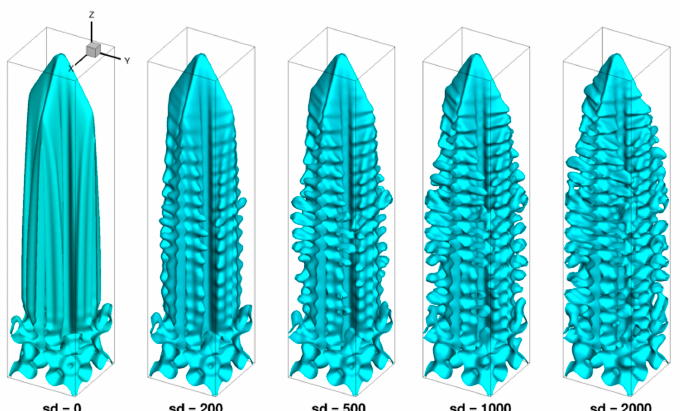
Figure 5. Effect of the magnitude of random noise on the isothermal solidification microstructure in 3D at 1617K.